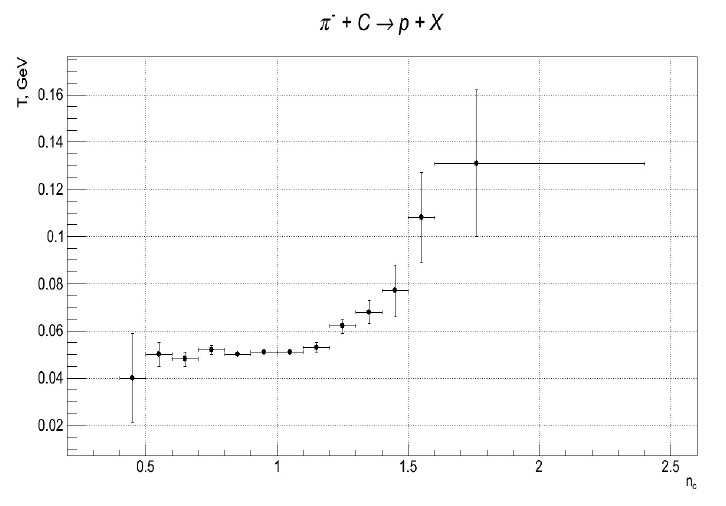
Figure 1. E ff ective temperature T vs cumulative number n c for